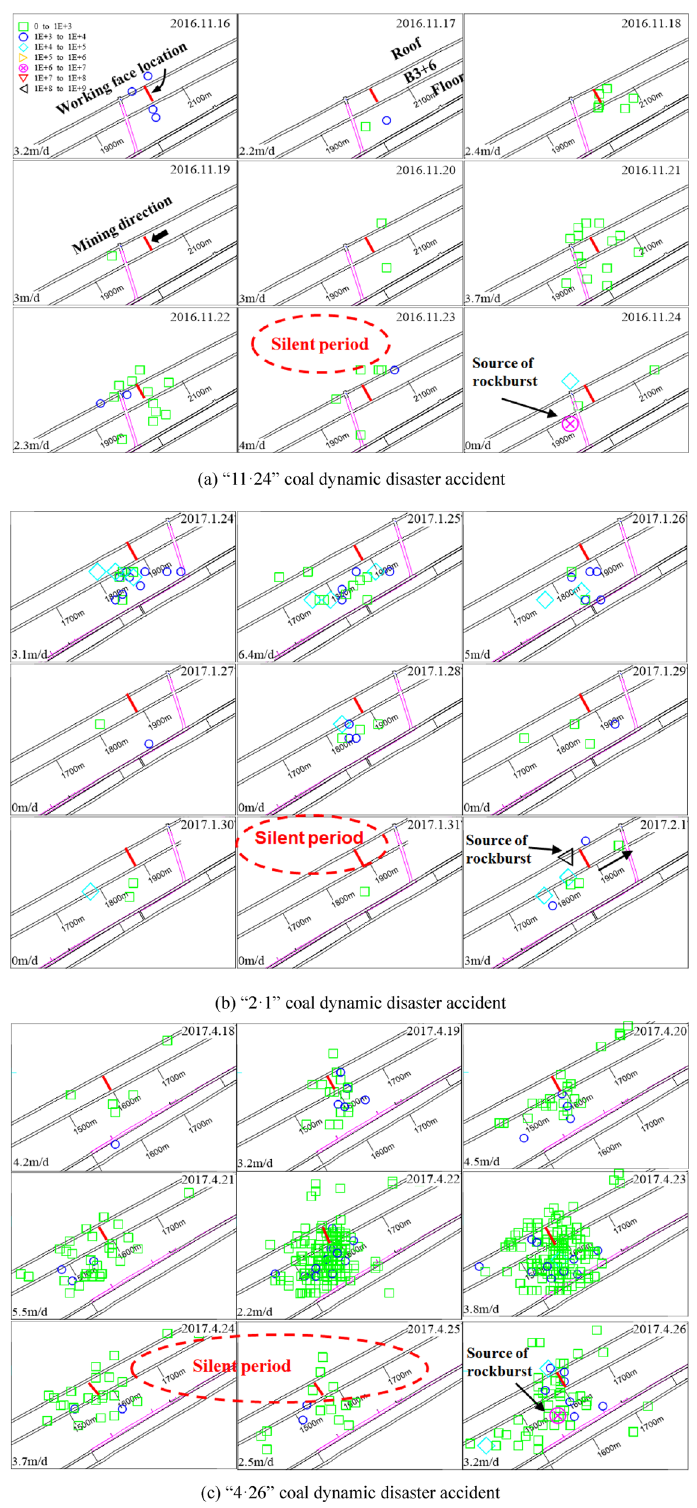
Fig. 7 Temporal-spatial evolu- tion of MS sources prior to coal dynamic disaster